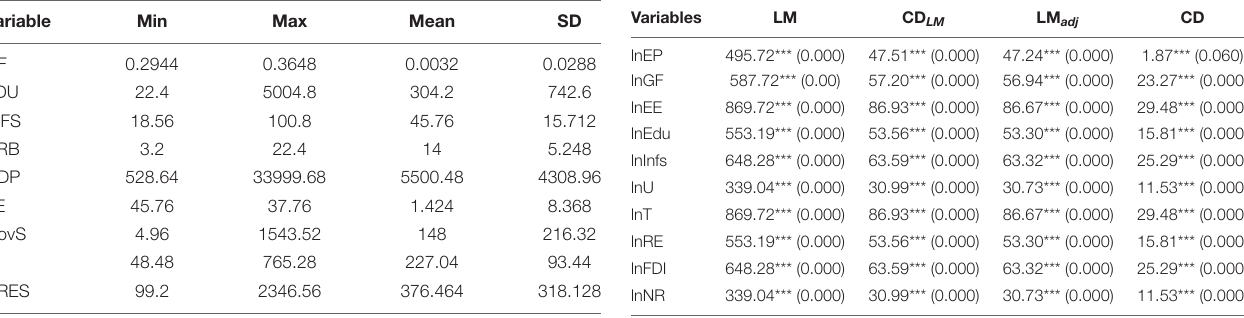
TABLE 1 | Descriptive statistics. TABLE 2 | Results of CD